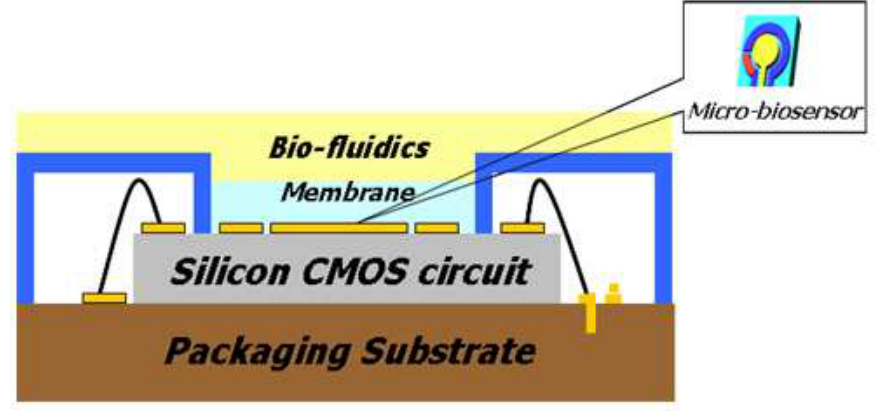
Figure 1. A conceptual drawing of the silicon CMOS integrable non-enzymatic micro-